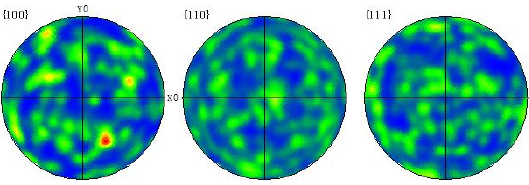
Figure 8. Polar diagrams of Al-Mg alloyed additive on different planes.